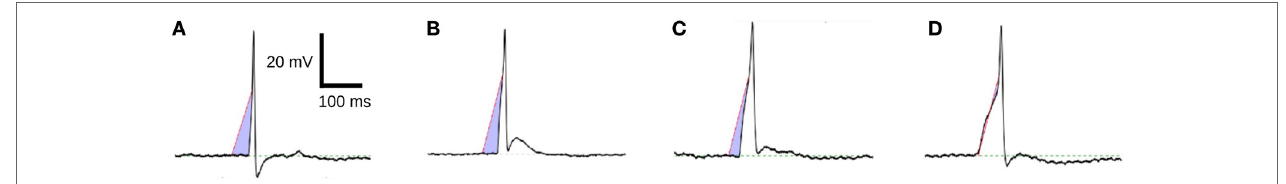
FIgURe 11 | Quantification of convexities of experimentally recorded APs. The C 25,30 convexity measures of signals (A–d) are − 630.98, − 525.68, − 366.16, and − 4.69,